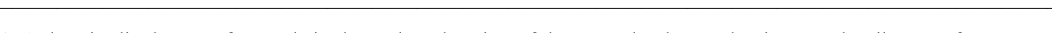
Fig. 1. A , longitudinal rows of crystals in the umbonal region of the ventral valve. B , laminae on the rib crest; furrow on the left is the transverse growth mark. C , cross-bladed lamination. D , E , close up of lamina surfaces. F , lamina surface altered by growth lines. G , H , set of laminae in the umbo of the ventral valve; one lamina (H) is less altered than the others. I , possible vertical fusion of two neighbouring laminae. J , rib crest composed of variously preserved laminae. K , thick diagenetic lamina. L , wrinkled surface of the diagenetic lamina. M , longitudinal section through the spondylium completely composed of diagenetic calcite; inner surface on the top consists of the vertically hatched crust. N , O , transversely broken valve showing laminar ribs (N) and diagenetic calcite in the rib interspace (O). P , diagenetic calcite lining the bottom of rib interspace and bordering with inner sublayer of planar laminae. A , N – P , ventral valve PIN 4921/661. B – D , F , I , J , dorsal valve PIN 4921/780. E , G , H , ventral valve PIN 4921/781. K – M , ventral valve PIN